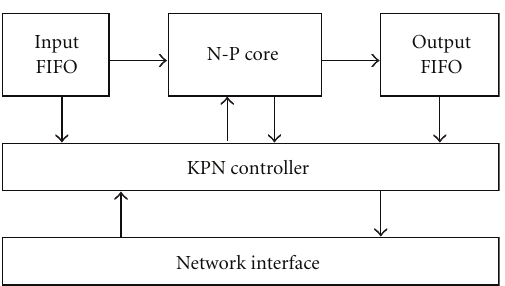
Figure 4: Block diagram of the KPN middleware for a nonpro- grammable core (N-P